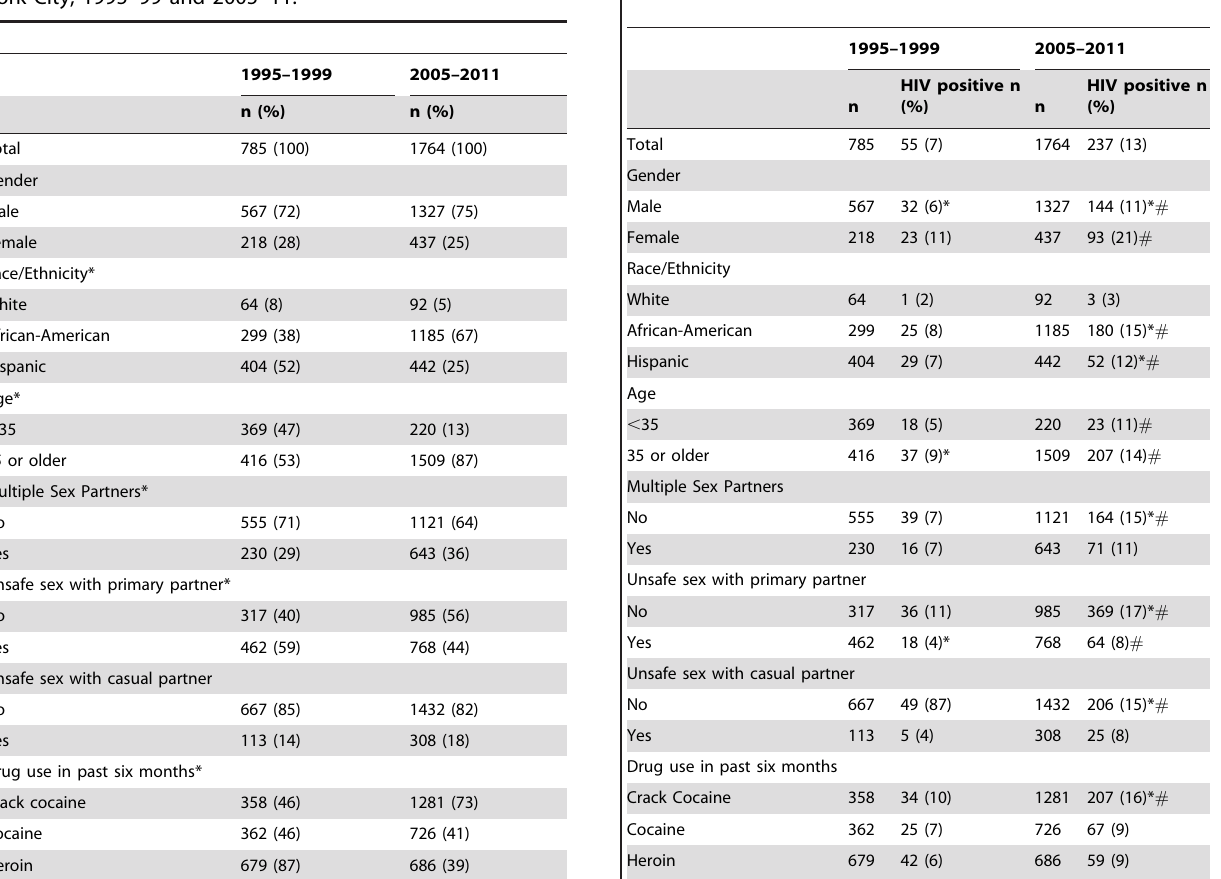
Table 1. Demographic and drug use characteristics and sexual risk behaviors among never-injecting drug users, New York City, 1995–99 and 2005–11.